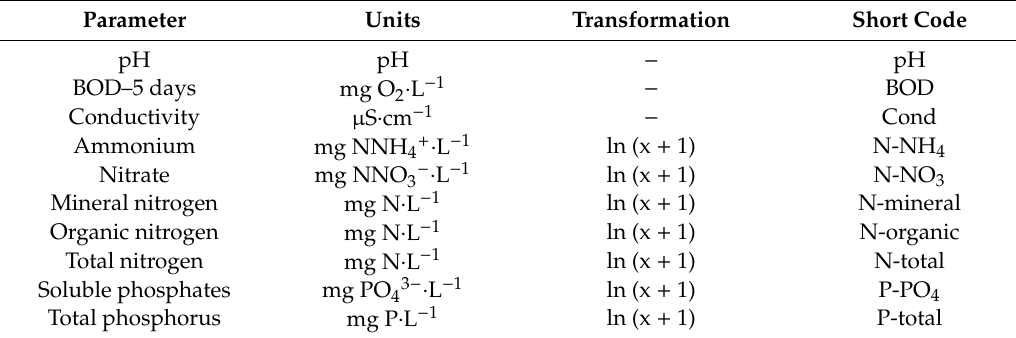
Table 1. List of chemical parameters analyzed in the surveyed